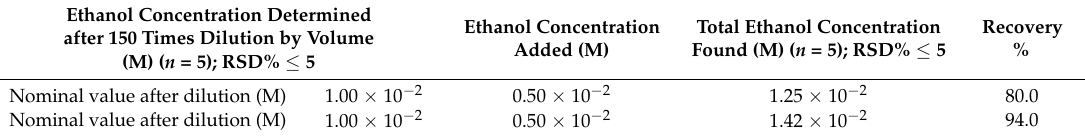
Table 4. Recovery tests by standard addition